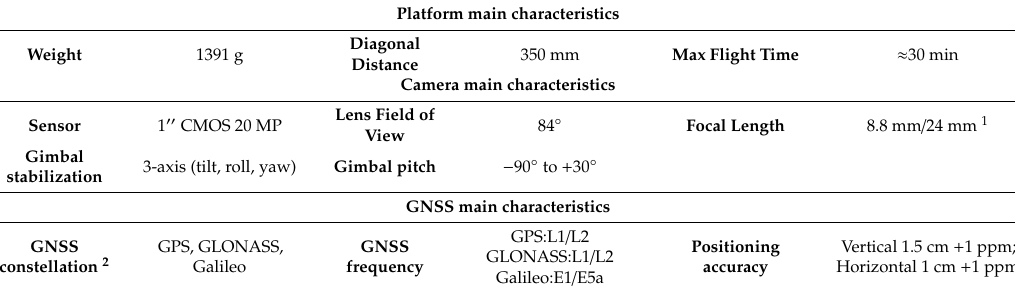
Table 3. Main characteristics of the DJI Phantom 4 RTK [67].